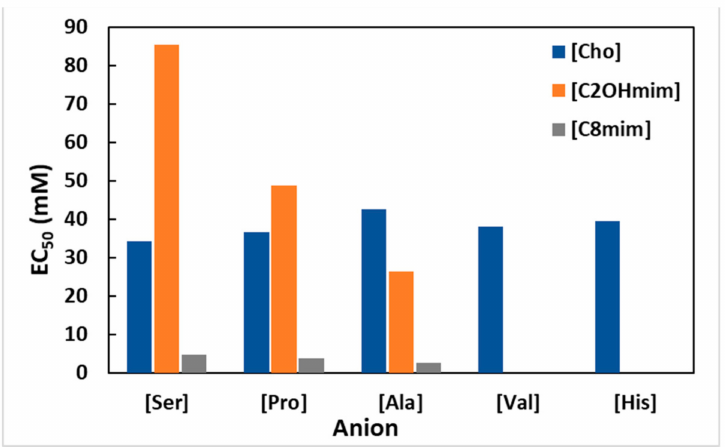
Figure 3. EC 50 values for the ILs towards A. fischeri studied by Foulet et al. [50] and Ghanem et al.